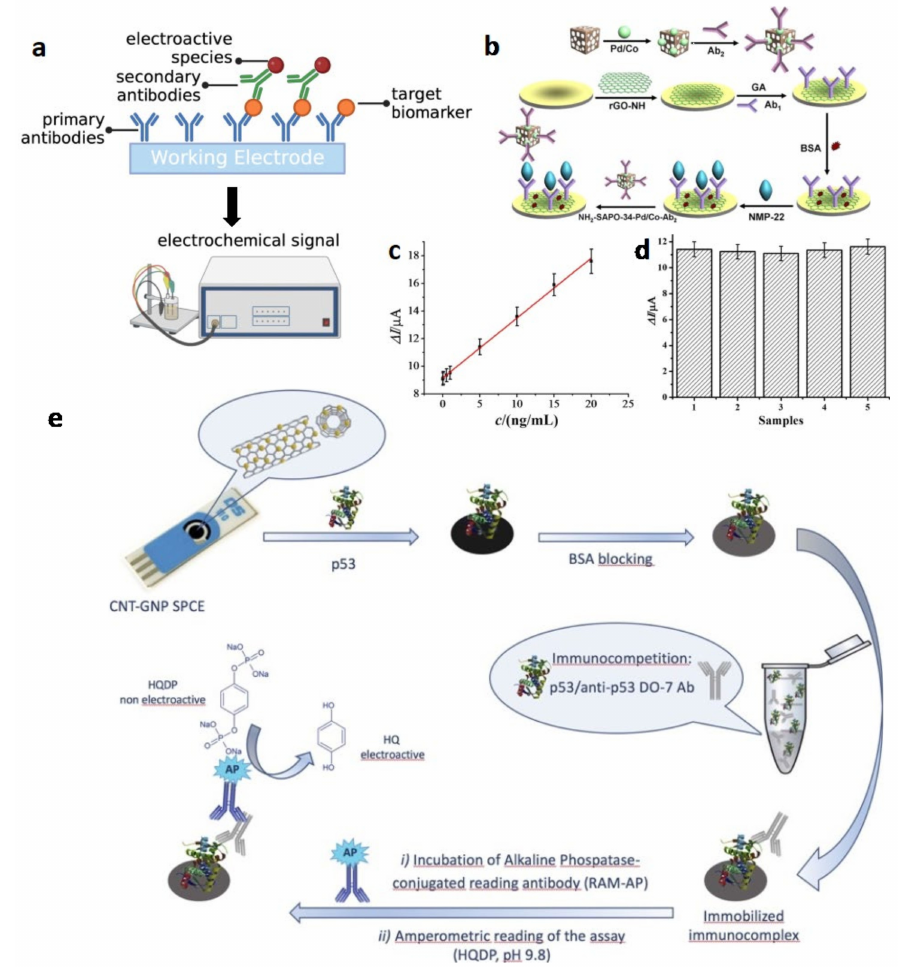
Figure 2. ( a ) Schematic of the sandwich-based model of the eELISA (Created with biorender.com, access date: 10 December 2022). ( b ) Schematic of the construction of the NH 2 -SAPO-34-Pd/Co-Ab 2 and the eELISA sensor for urine cancer biomarker detection. ( c ) Calibration curve of the eELISA sensor toward different concentrations of NMP-22. ( d ) Amperometric response of the eELISA sensor to pure NMP-22 and NMP-22 with interfering substances (from left to right: NMP-22, NMP-22 + BSA, NMP-22 + vitamin C, NMP-22 + trioxypurine, NMP-22 + glucose). (Reprinted with permission Ref. [33]. Copyright © The Author(s)) ( e ) Schematic of the fabrication of the CNT/GNP SPCE competitive immunosensor. (Reprinted with permission Ref. [35]. Copyright © 2017 Elsevier B.V.